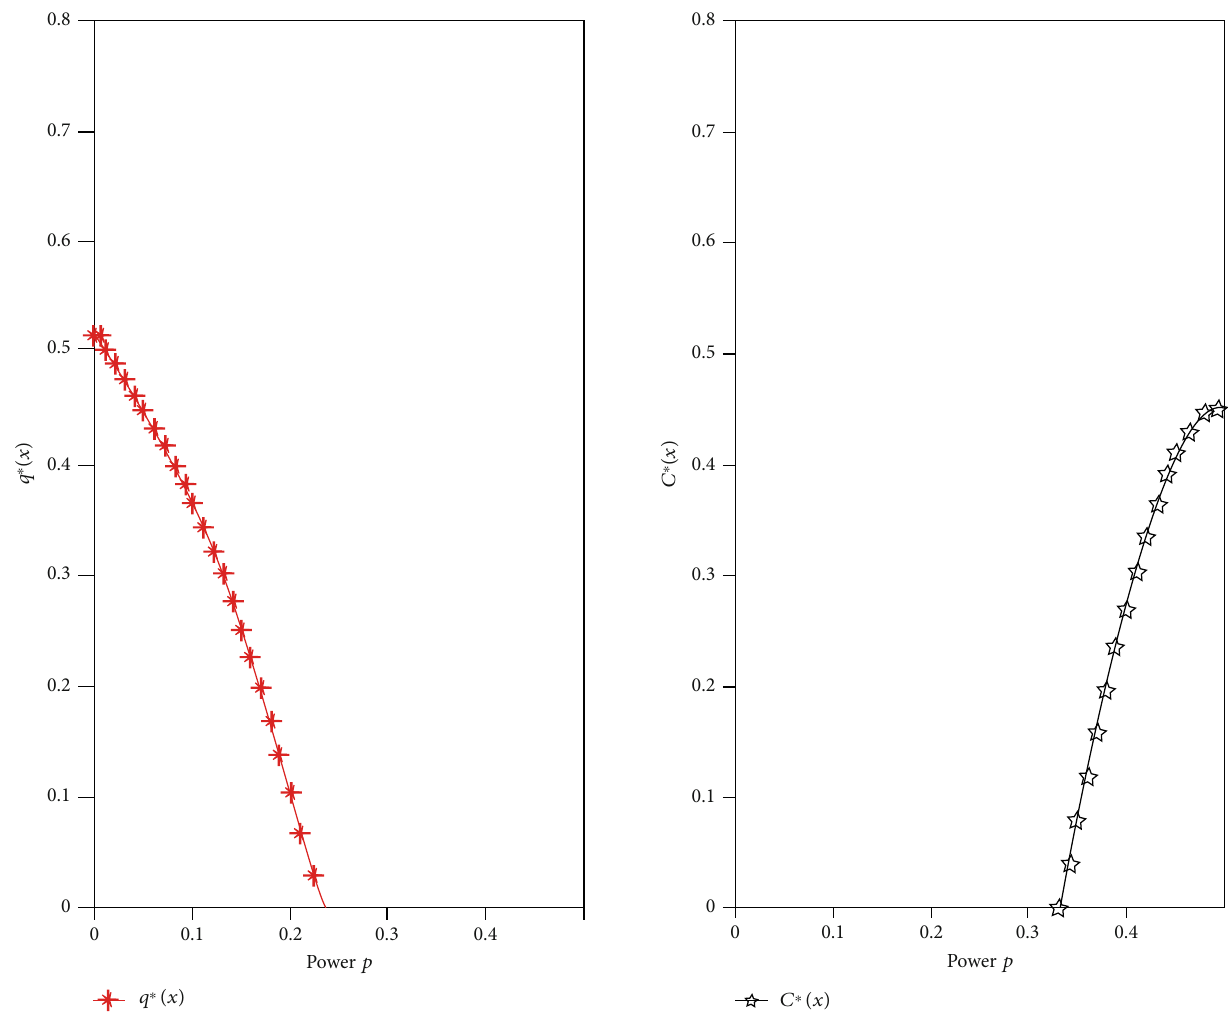
Figure 2: q ∗ ð x Þ and c ∗ ð x Þ change with p without VaR constraint.